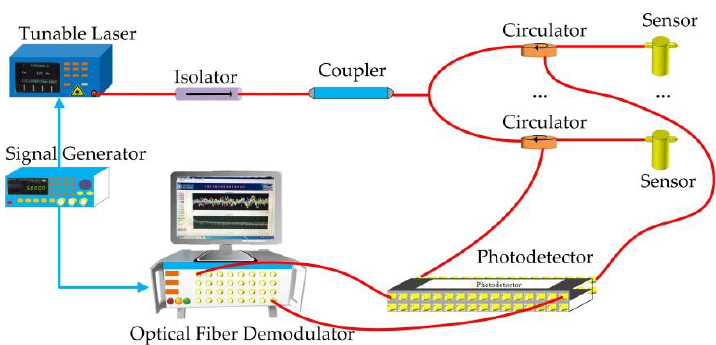
Figure 4. Schematic diagram of fiber optic vibration sensing system.